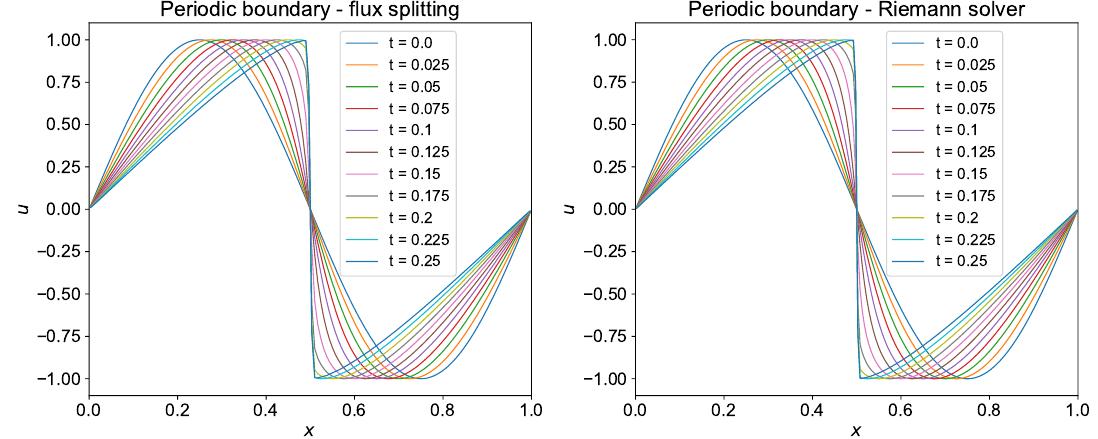
Figure 11. Evolution of shock from sine wave ( u 0 = sin ( 2 π x ) ) computed using conservative form of inviscid Burgers equation. The reconstruction of the field is done using WENO-5 scheme, and flux splitting and Riemann solver approach is used to compute the nonlinear